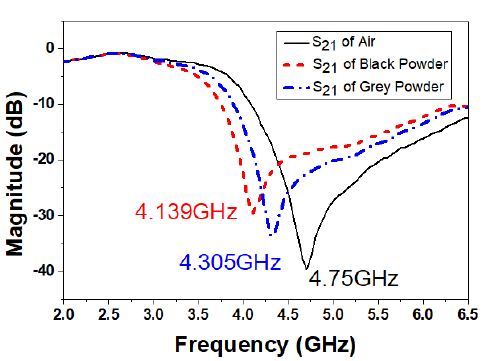
Figure 16. Measured S 21 of Anthracite (black powder) and Bituminous (grey